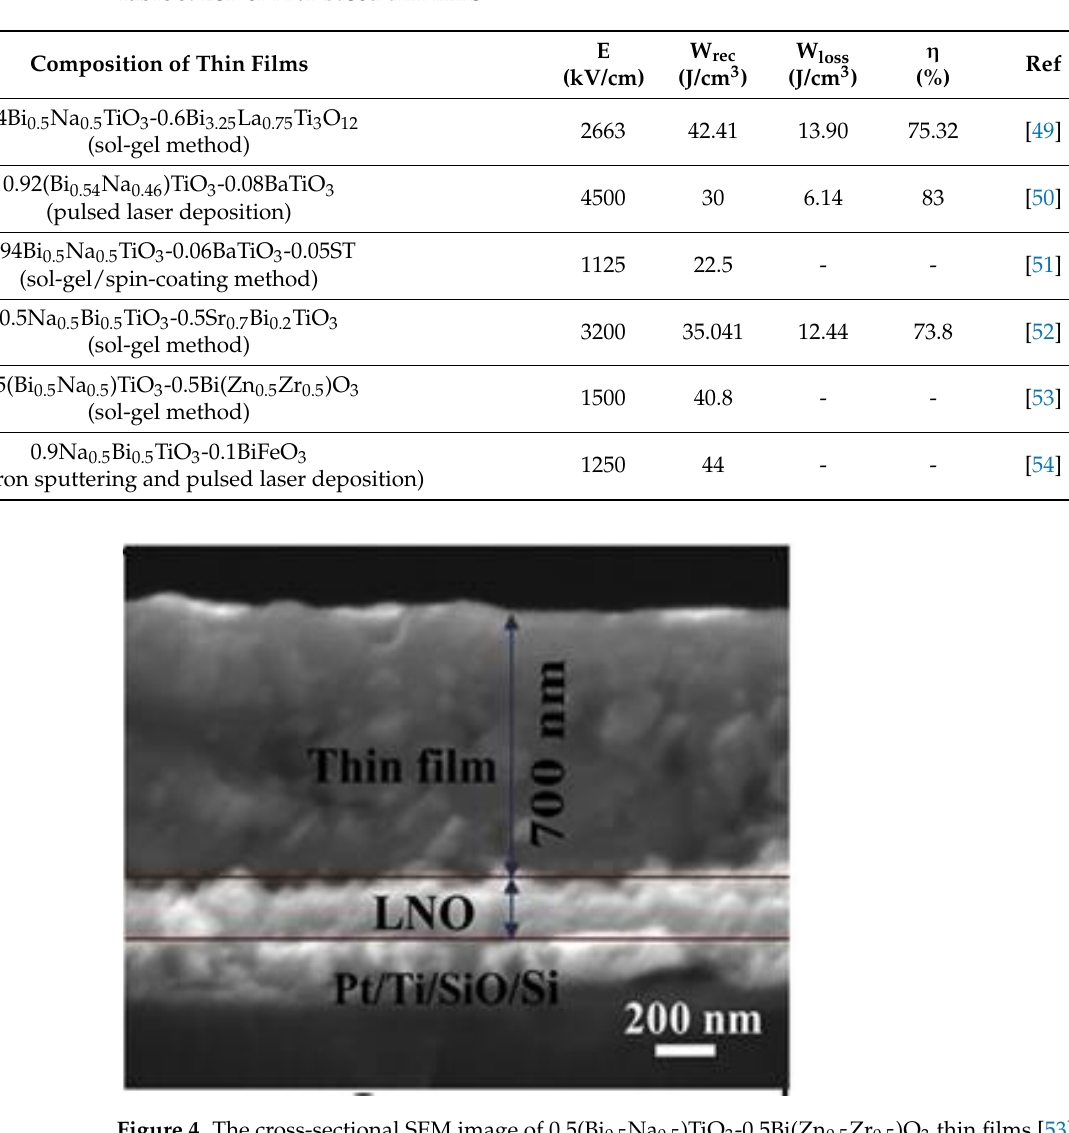
Table 5. ESP of BNT-based thin films.